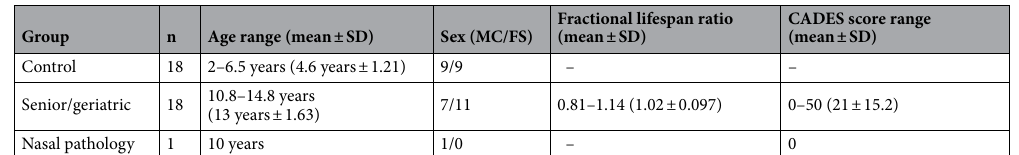
Table 1. Summary demographic information for the study dogs. Fractional life span was not calculated for the control group or the nasal pathology case and are not reported in this dataset. Additionally CADES score was not evaluated in the control group but was evaluated in the nasal pathology case due to his age at the time of testing.